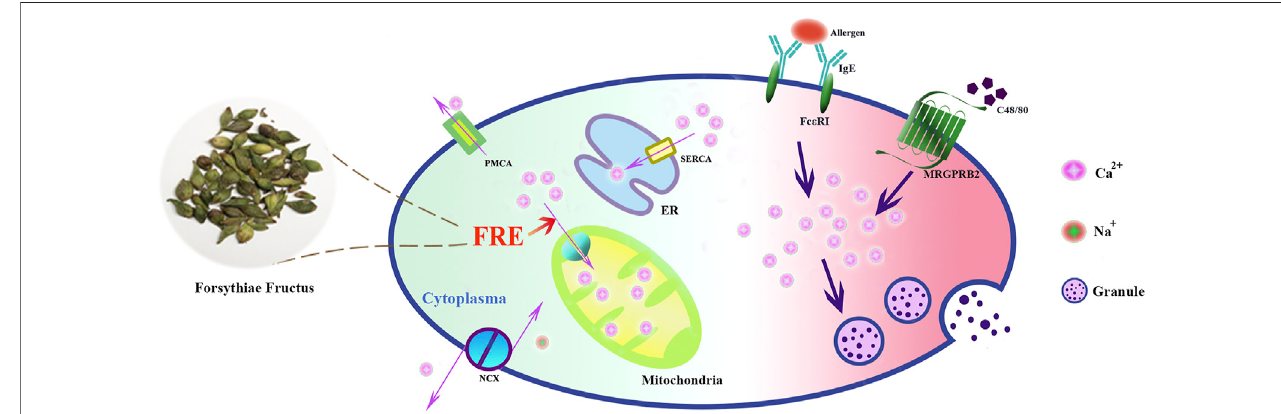
FIGURE 8 | Schematic graph depicting how FRE dampened MC degranulation. FRE decreased Ca 2+ [c] by enhancing Ca 2+ [m] uptake, thereby suppressed IgE/Fc ε RI- mediated and Mrgpr-mediated MC degranulation.